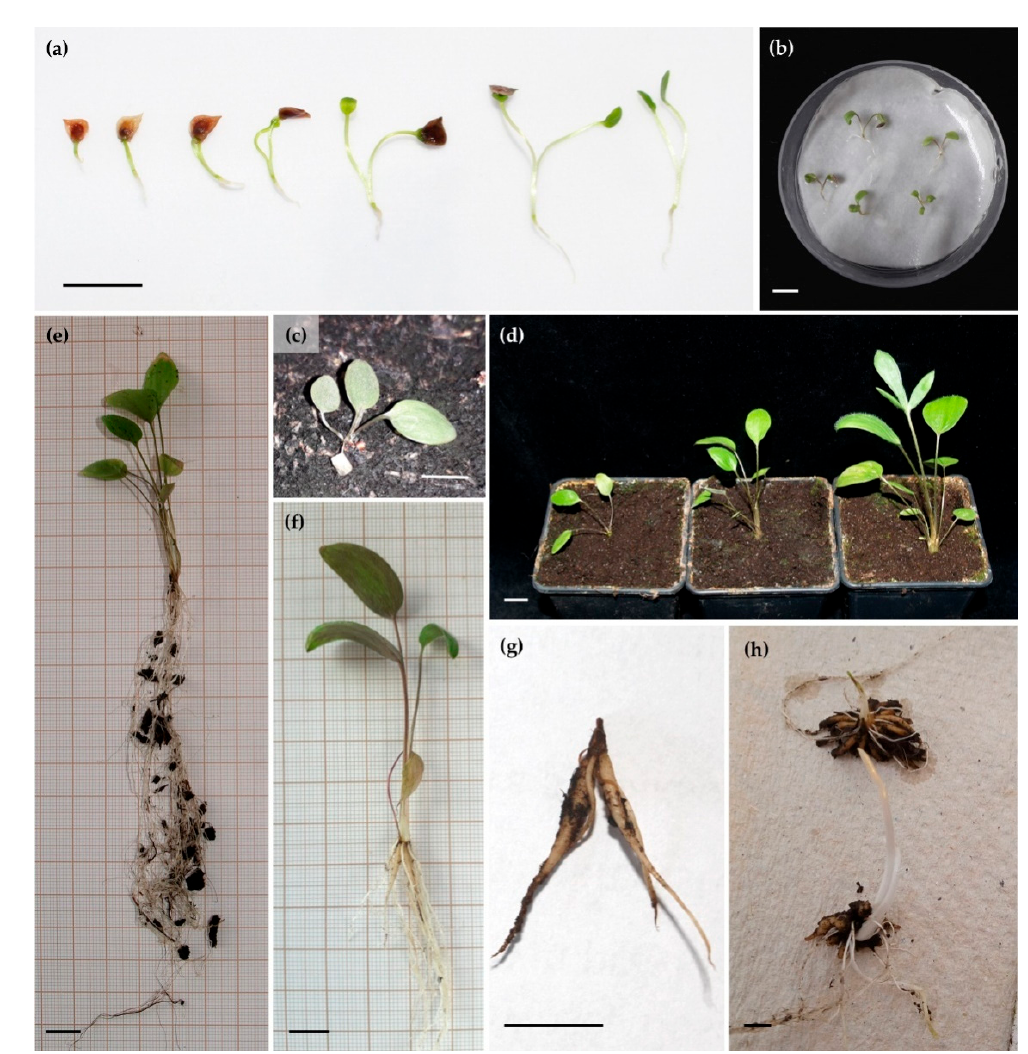
Figure 7. Seed germination and seed-derived plant development of R. illyricus under ex situ conditions: ( a ) epigeic seed germination between 10–20 days after sowing, ( b ) seedlings with cotyledons before potting, ( c ) two-month-old seedling with dried cotyledons and juvenile leaves, ( d ) three-month-old seed-origin plants, ( e ) morphological structure of above- and belowground organs of a seed-origin plant at the end of the first growing season, ( f ) individual of generative origin with some tuberous roots at the end of the first growing season, ( g ) cluster of tubers after the first overwintering, ( h ) three-year-old plant obtained from seed (top) and its vegetative progeny (bottom) before winter. Scale bar = 1 cm.